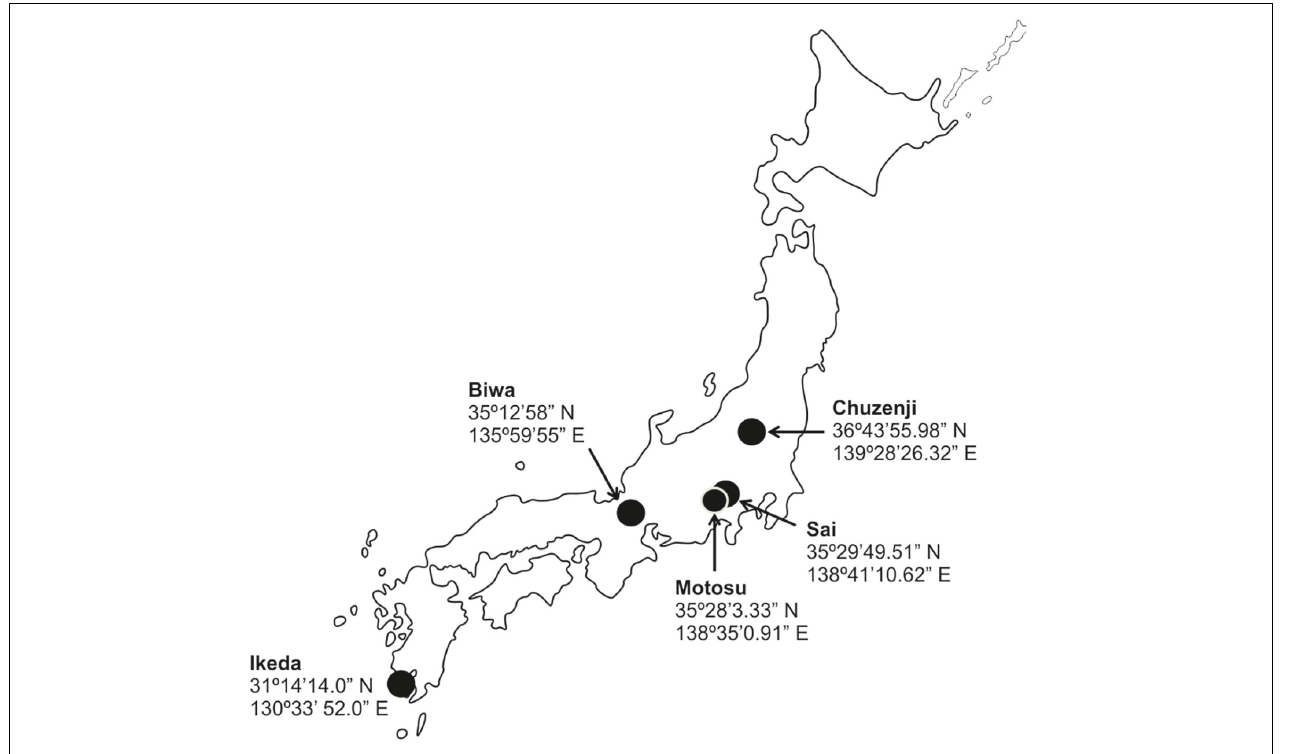
FIGURE 1 | Map of Japan with the location of the sampled lakes.